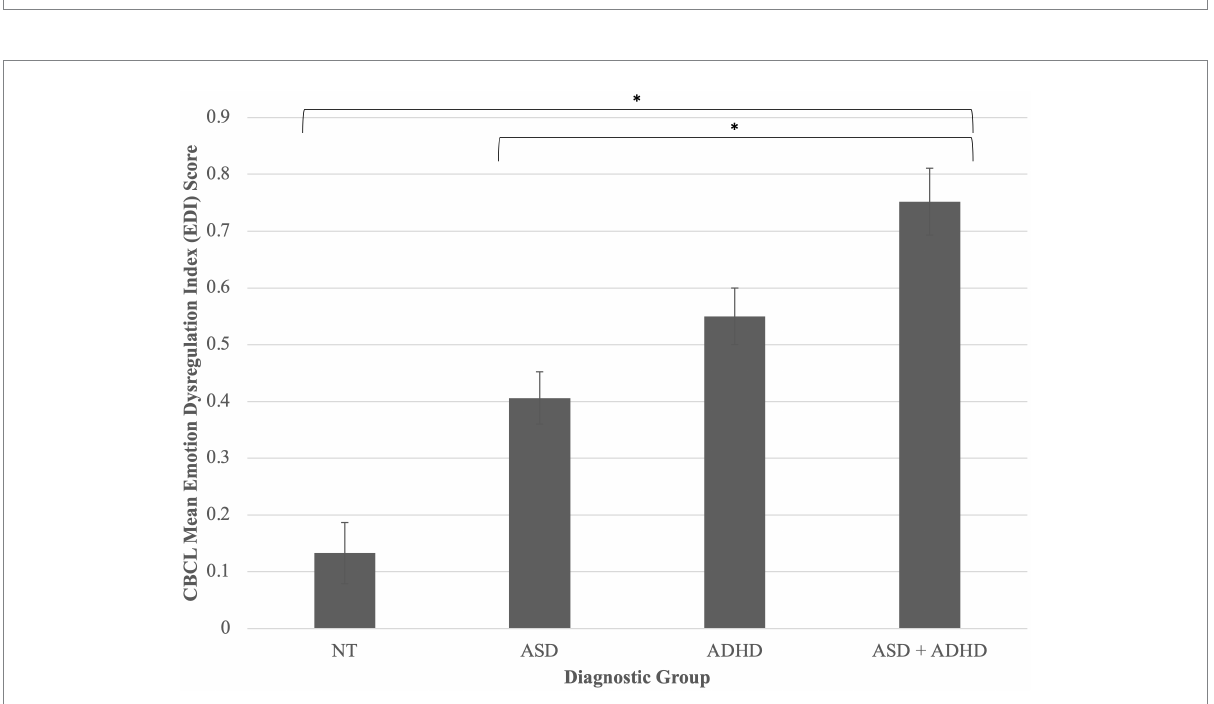
FIGURE 4 Diagnostic group differences in emotion dysregulation. Children with co-occurring autism and ADHD had greater caregiver-reported emotion dysregulation than NT children, p = <0.001, and children with autism alone p < 0.001. FAA was not significantly predictive of emotion dysregulation. * p < 0.05. Error bars are +/ − one standard error. Difference between ASD + ADHD and ADHD groups trends toward significance ( p =